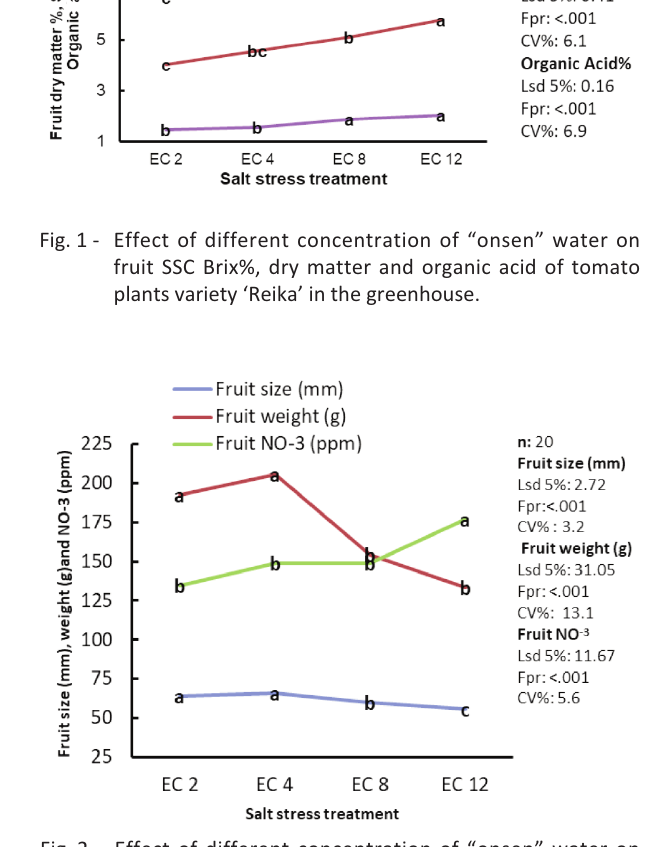
Fig. 2 ­ Effect of different concentration of “onsen” water on fruit size, weight and NO ­3 of tomato plants variety ‘Reika’ in the